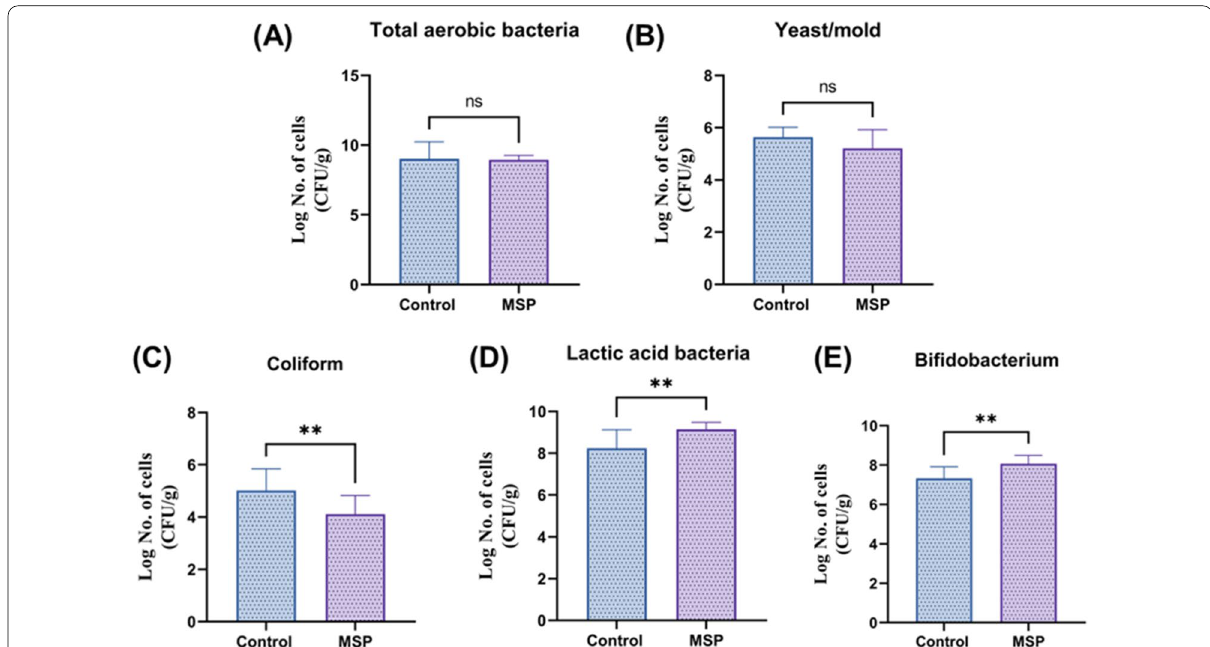
Fig. 1 Comparison of microbial population of piglet feces within MSP and control group. A Quantitative analysis of total aerobic bacteria between MSP and control groups, B yeast/mold, C coliform, D lactic acid bacteria and E Bifidobacterium (** p <